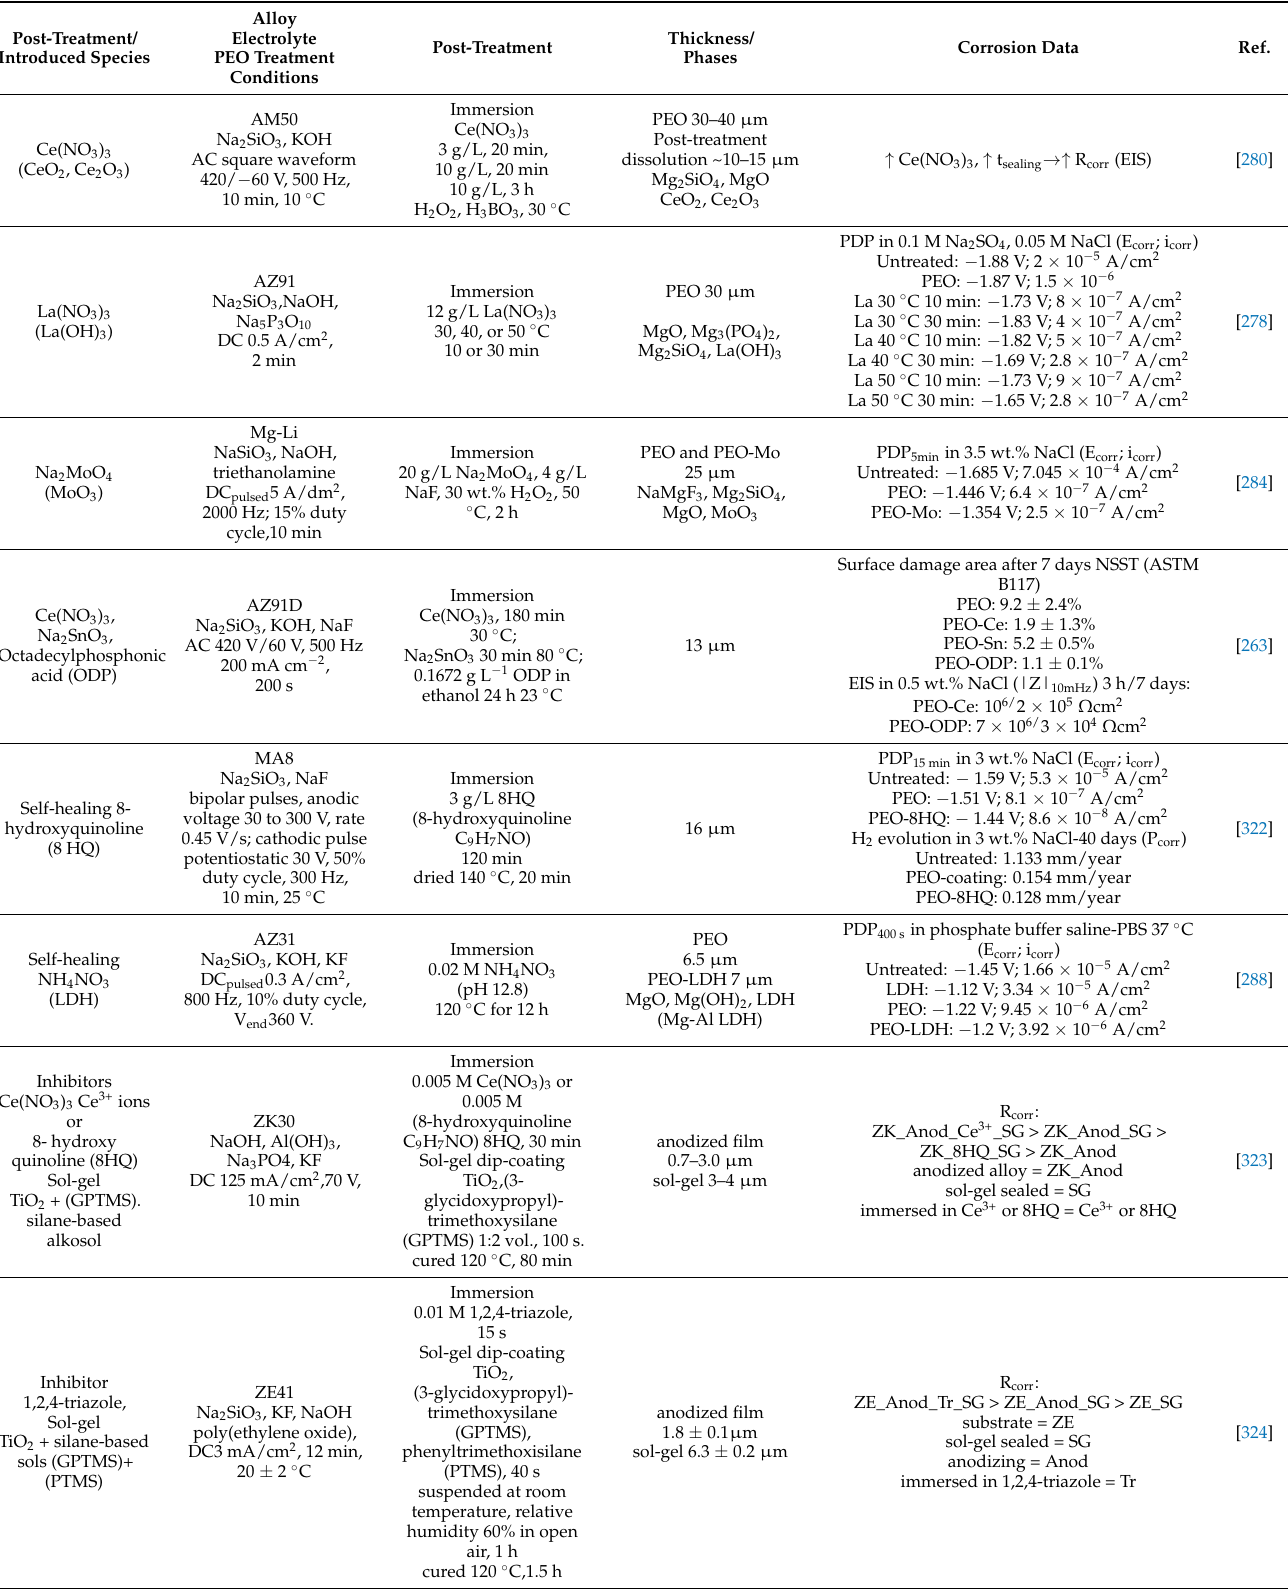
Table 6. PEO process parameters with post-treatment procedures and their effect on corrosion